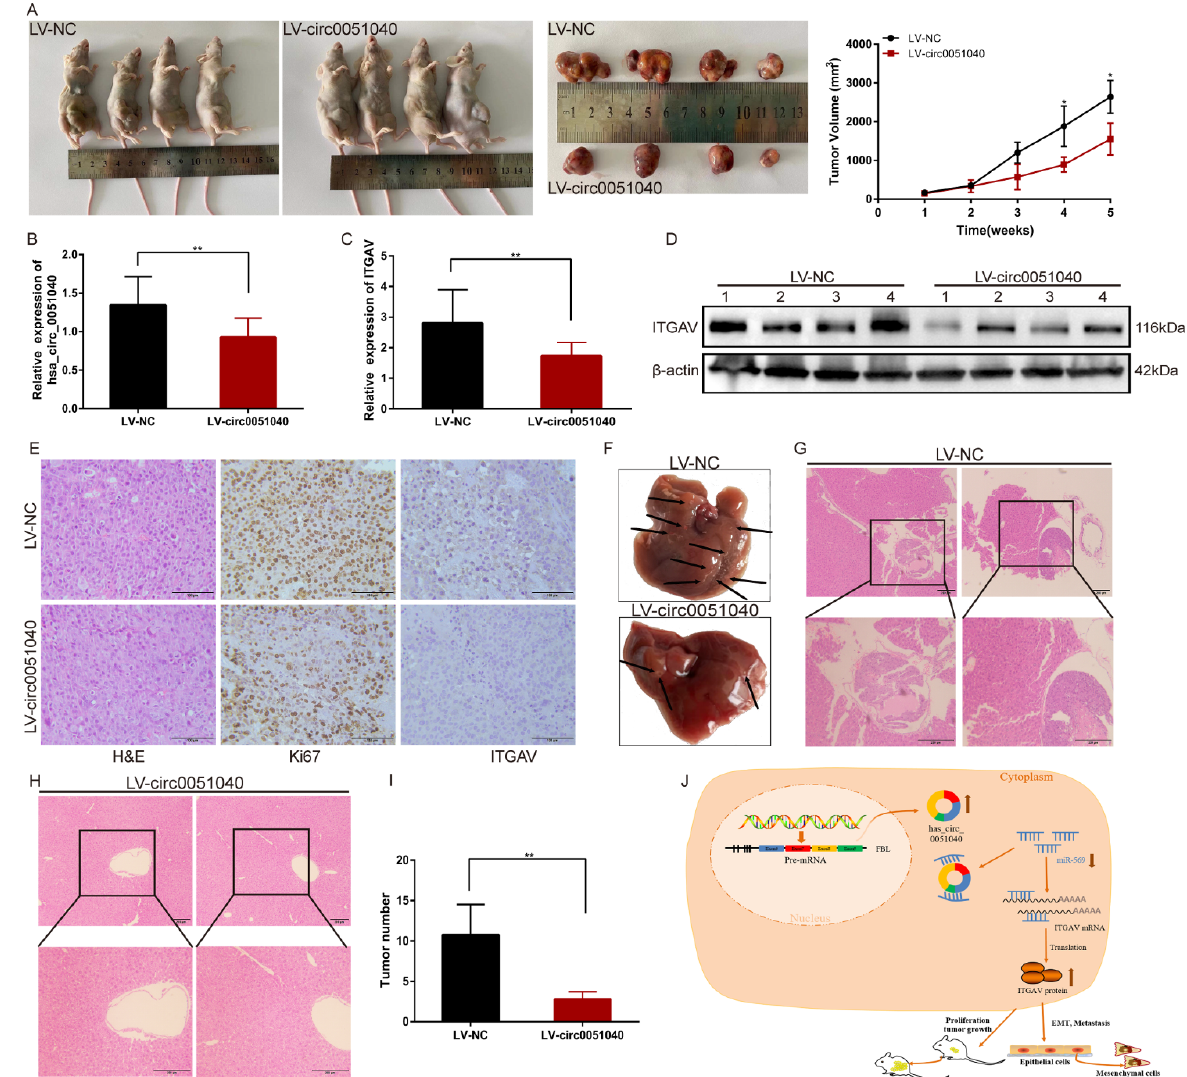
Figure 7. Knockdown of hsa_circ_0051040 suppresses tumor growth and metastasis in vivo. ( A ) Image of nude mice injected with PLC/PRF/5 cells subcutaneously (1 × 10 7 cells per mouse, n = 4 mice per group). Tumors collected from mice were measured one month after subcutaneous injection. ( B , C ) The relative expression levels of hsa_circ_0051040 and ITGAV in tumors were determined by qRT-PCR analysis. The data are presented as the means ± SD. ( D ) Western blot analysis of ITGAV protein levels in dissected tumors transduced with hsa_circ_0051040 knockdown lentiviral vectors. ( E ) H&E staining showed the structure of tumors. Immunohistochemical staining of tumors for Ki-67 and ITGAV expression. Scale bar, 100 μ m. ( F ) Representative images of tumor foci in the liver of two groups. ( G , H ) H&E staining images of the liver in two groups. ( I ) The number of tumor foci was calculated in two groups. ( J ) Schematic diagram of the regulatory mechanism of the hsa_circ_0051040/miR-569/ITGAV axis in promoting HCC proliferation and metastasis. The error bar indicates the SD. * p < 0.05; ** p < 0.01. Taken together, these findings provide evidence that hsa_circ_0051040 regulates ITGAV expression through miR-569, contributing to the proliferation and metastasis of HCC (Figure 7J).